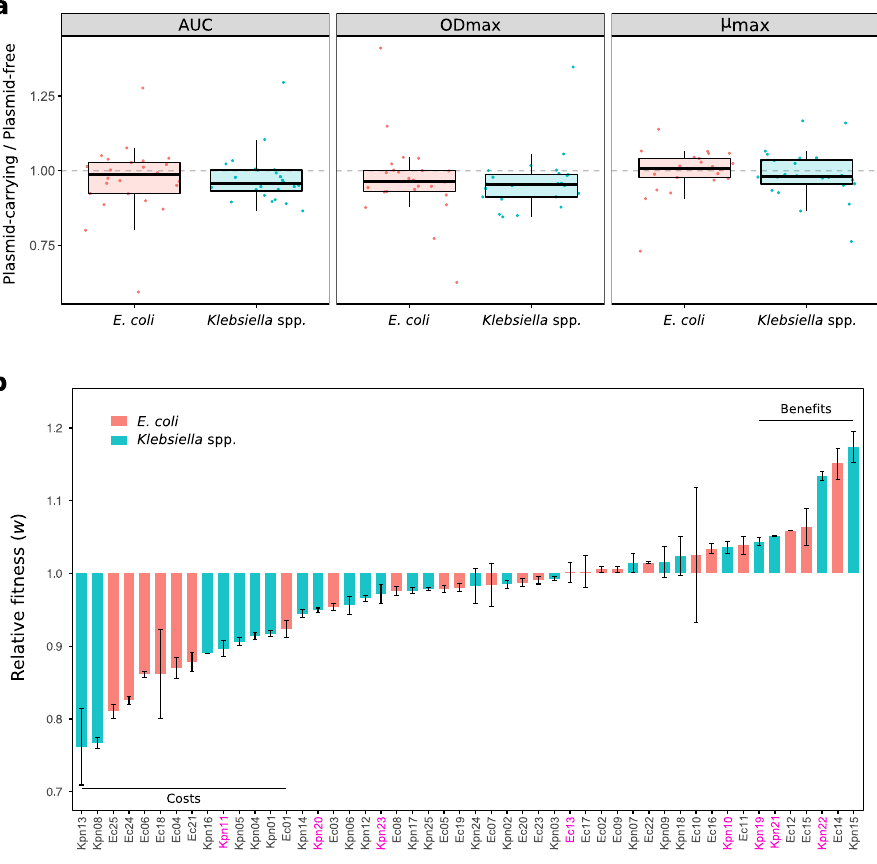
Fig. 2 pOXA-48_K8 fi tness effects in a set of ecologically compatible wild-type enterobacteria. a Relative values of growth curve parameters (plasmid- carrying/plasmid-free isogenic clones): area under the growth curve (AUC), maximum optical density (OD max ), and maximum growth rate ( μ max ), represented as boxplots for E. coli (red) and Klebsiella spp. (blue) isolates separately. Horizontal lines inside boxes indicate median values, the upper and lower hinges correspond to the 25th and 75th percentiles, and whiskers extend to observations within 1.5 times the interquartile range. Dots represent each relative value. Values <1 indicate a reduction in these parameters associated with plasmid acquisition. Four and six biological replicates of the growth curves were performed for the wild-type isolates and the transconjugants, respectively (see Supplementary Figs. 1 and 2). b Relative fi tness ( w ) of plasmid- carrying clones compared with plasmid-free clones obtained by competition assays (red, E. coli ; blue, Klebsiella spp. see “ Methods ” for details). Values <1 indicate a reduction in w due to plasmid acquisition; values >1 indicate an increase in w . Bars represent normalised relative fi tness after subtracting the effect of pBGC (average result of fi ve independent biological replicates of the competition pOXA-48-carrying vs. pBGC-carrying strains divided by the average result of fi ve independent biological replicates of the competition pOXA-48-free vs. pBGC-carrying strains), and error bars represent the propagated standard error. Two horizontal lines indicate those clones showing signi fi cant costs or bene fi ts associated with carrying pOXA-48 plasmid (Bonferroni corrected two-sampled t test, P < 0.05). The names of the clones for which the relative fi tness was calculated using E. coli strain J53 carrying the pBGC vector, instead of the pBGC-carrying parental strain, are indicated in pink. Source data are provided as Source data fi